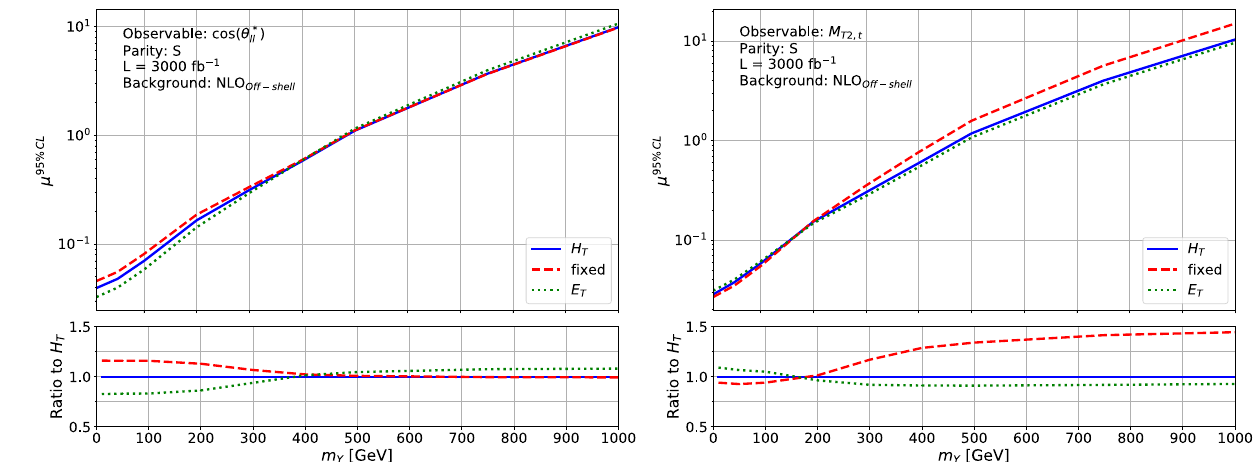
Fig. 17 Comparison of signal strength exclusion limits computed with different central scale choices for the background using the scalar medi- atorDMmodelandaluminosityof L = 3000fb − 1 .Forthiscomparison